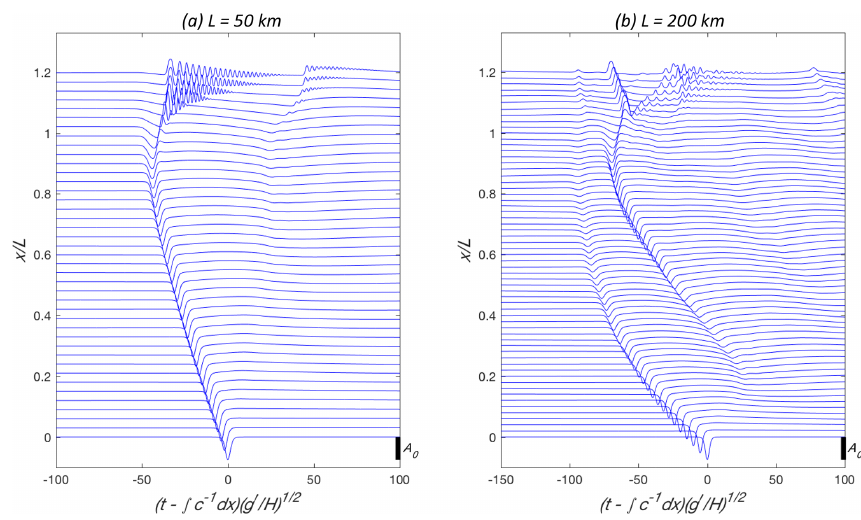
Figure 6. rG numerical solutions for h 1 = 50m, h 20 = 450m, g (cid:48) = 0 . 005ms − 2 , f = 10 − 4 s − 1 , and A 0 = − 25m. (a) L = 50km and (b) L = 200km. The wave amplitude η(x,t) is shown at x/L as a function of normalized shifted time, − s(g (cid:48) /H) 1 / 2 , where H = h 1 + h 20 . The initial wave amplitude is indicated by the scale on the lower right of each panel.